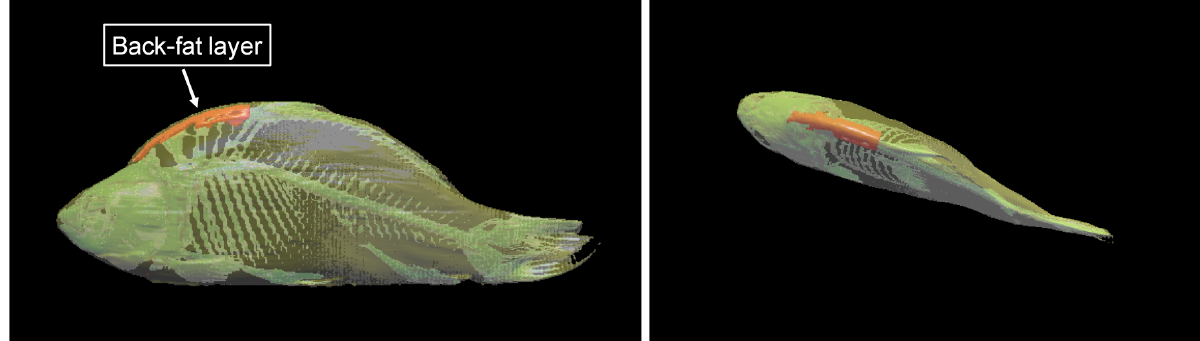
Figure 6. 3-D model of a mirror carp created with 3D-Doctor software showing the back fat from the beginning of the back to the beginning of the dorsal fin.